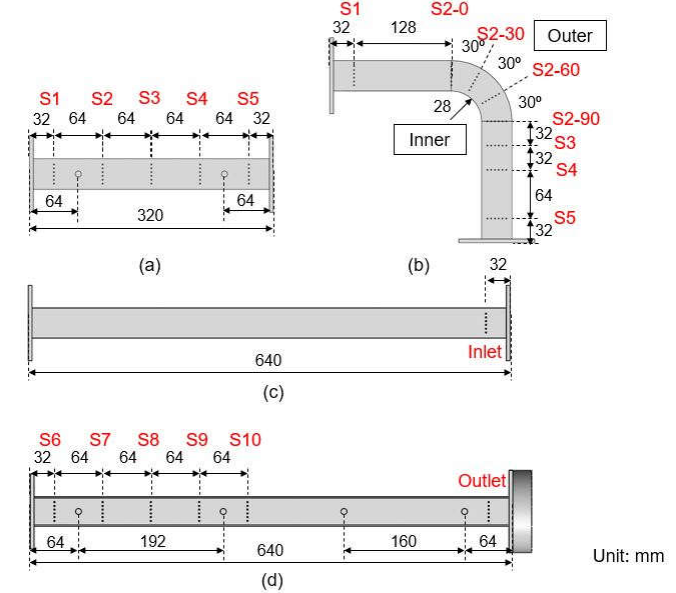
Figure 2. Diagrammatic sketch of measurement points on pipes (top view): ( a ) straight pipe; ( b ) curved pipe; ( c ) upstream pipe; ( d ) downstream pipe [18].